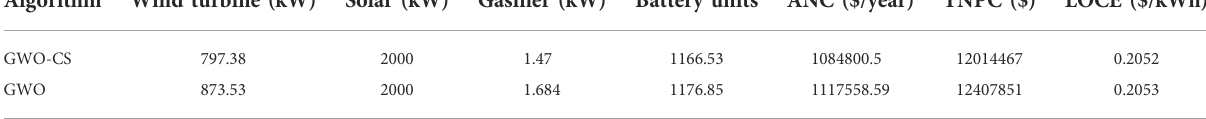
TABLE 3 The optimal sizing outcome achieved from adopted techniques.